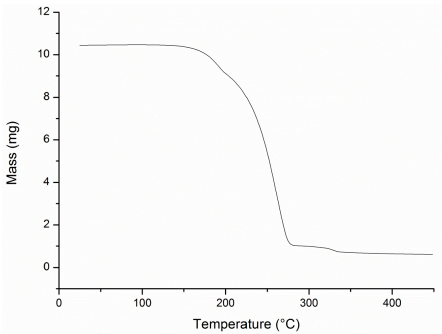
Figure A10. TGA of Compound ( L4 ), showing that no solvent is present within the structure, which is in line with the elemental